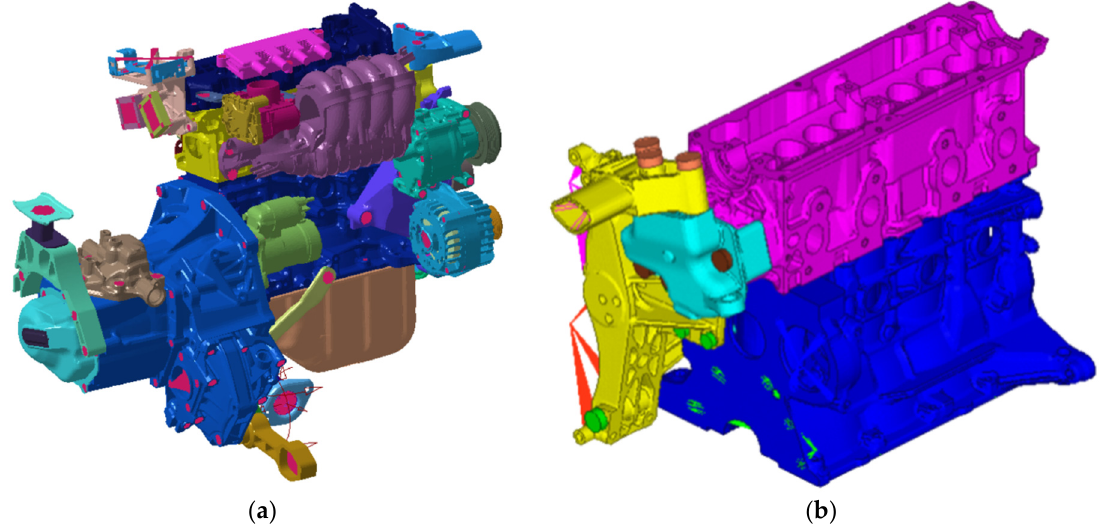
Figure 1. ( a ) Full CAD model of the 4-cylinder 4-stroke petrol engine; ( b ) simplified model adopted for the FEM simulations.